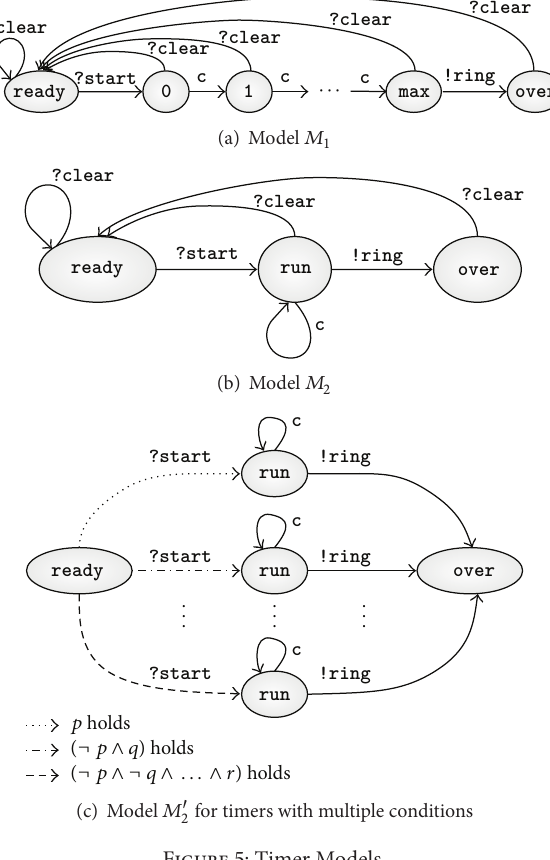
(c) Model 𝑀 󸀠 2 for timers with multiple conditions Figure 5: Timer